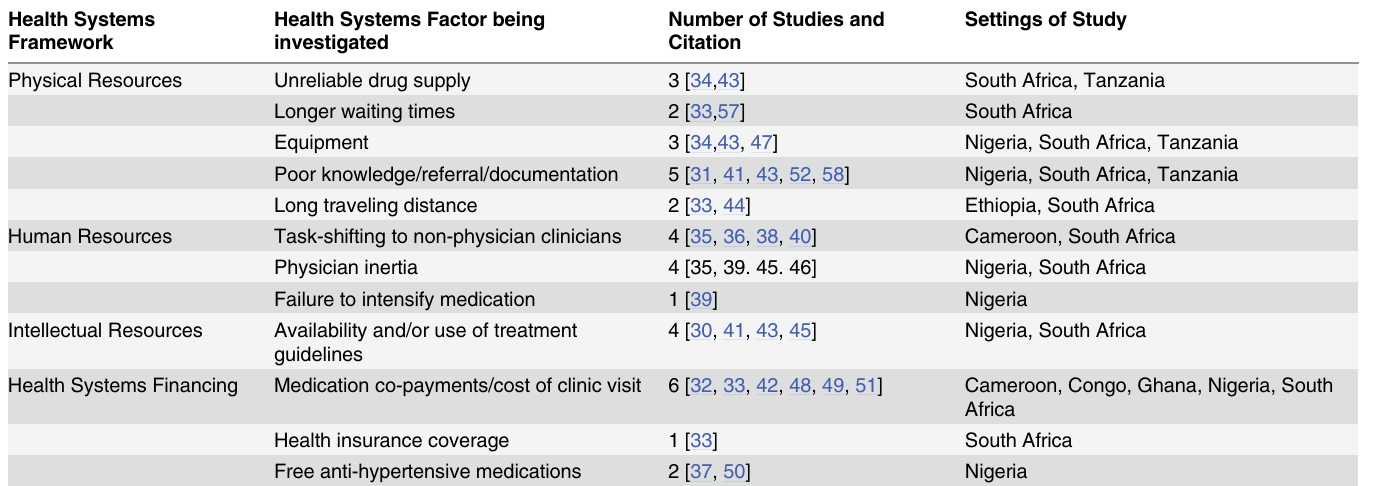
Table 3. Themes generated from reviewed